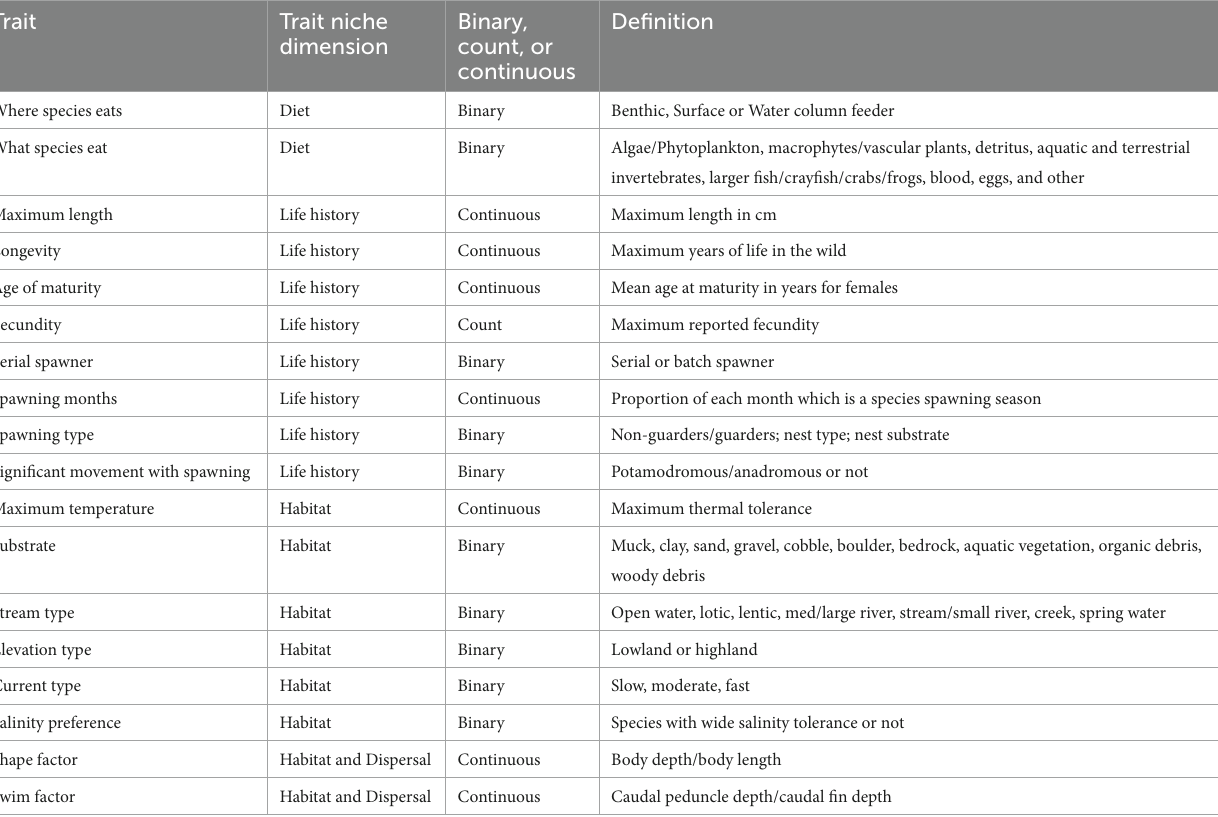
TABLE 1 Fish traits used for calculating functional beta